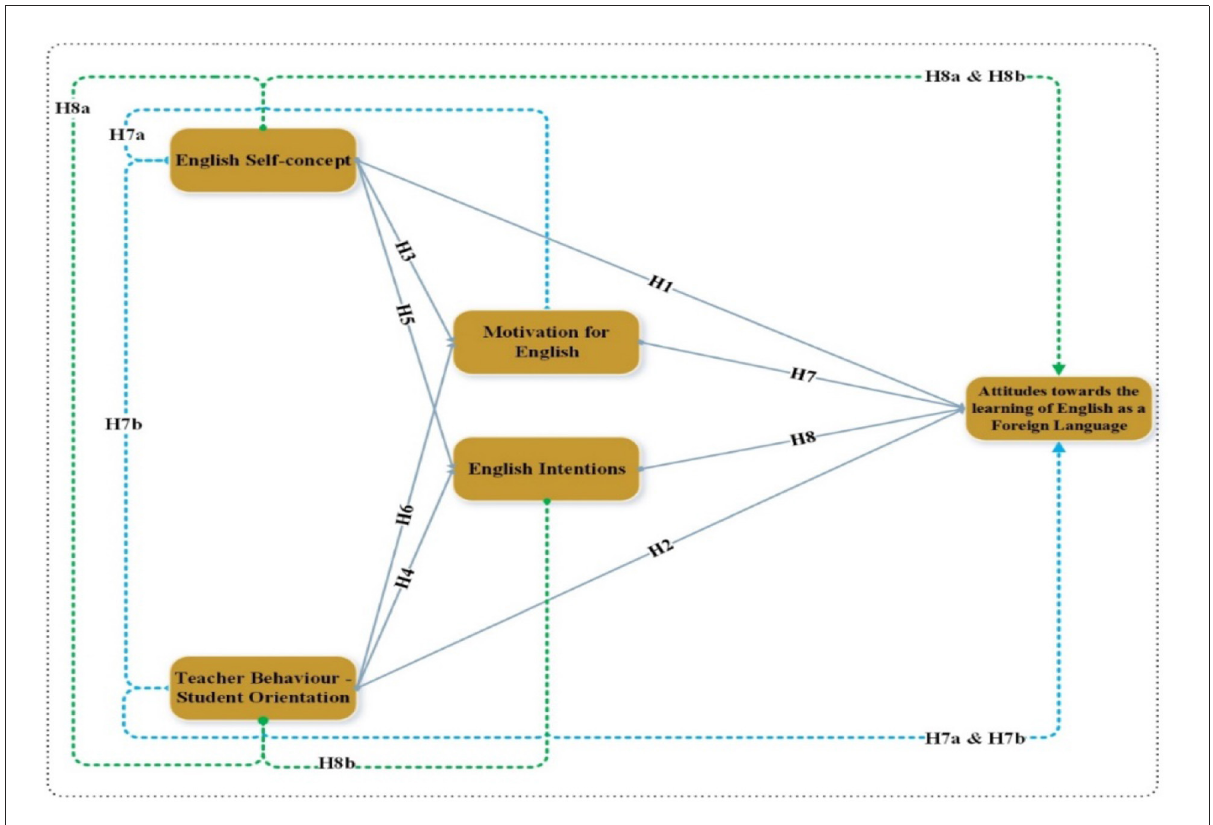
FIGURE1 Conceptual framework.